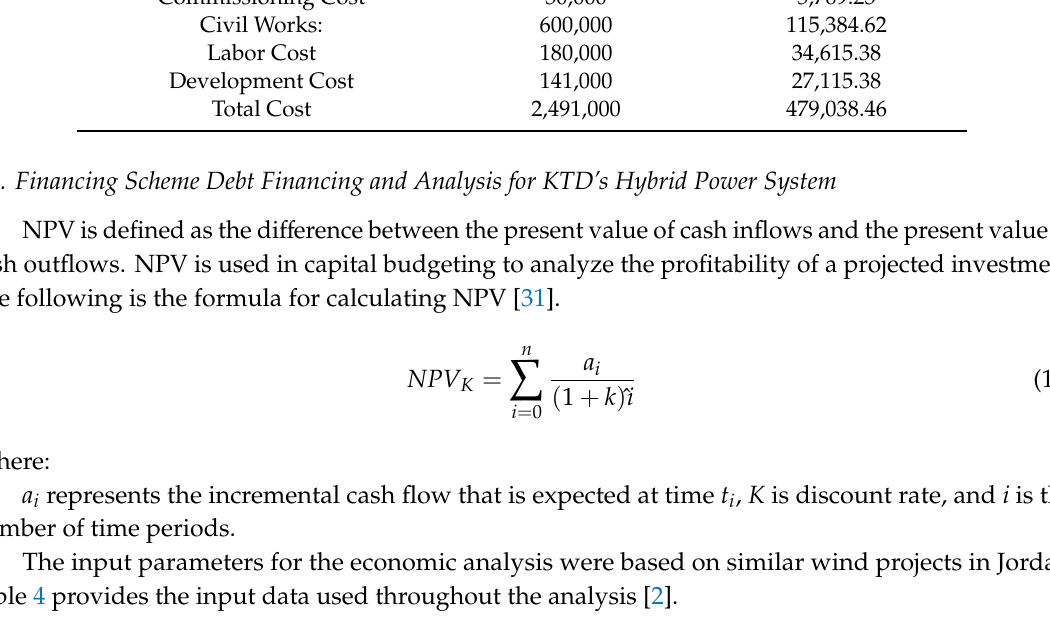
Table 4. Input data for financial analysis for KTD’s hybrid